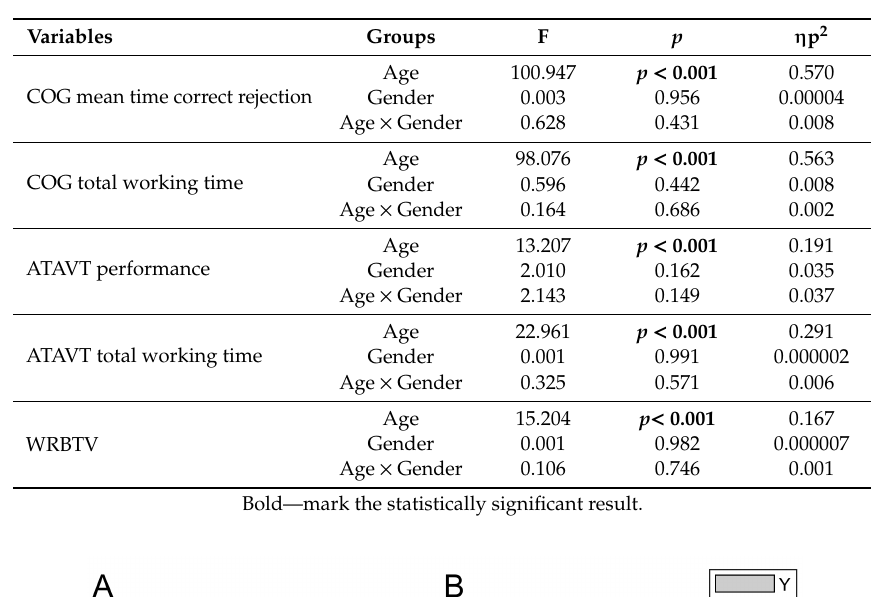
Table 2. The 2 × 2 results of 2 × 2 between-subjects Age × Gender ANOVAs on the measures of selective attention (COG mean time correct rejections and total working time), of tachistoscopic perception (ATAVT tachistoscopic perception and total working time) and risk assumption (WRB-TV). The table shows Fisher coe ffi cients (F) the associated probability ( p < 0.0018), and the e ff ect size (partial eta-squared, η p 2 ).